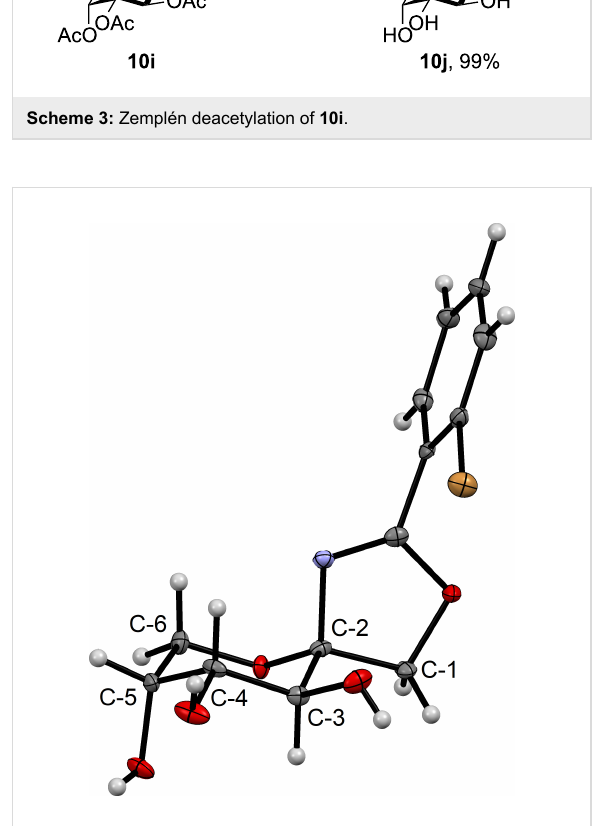
Figure 2: Molecular structure of 10j . Ellipsoids are given at the 50% probability level. Grey = carbon, red = oxygen, white = hydrogen, purple = nitrogen, orange =